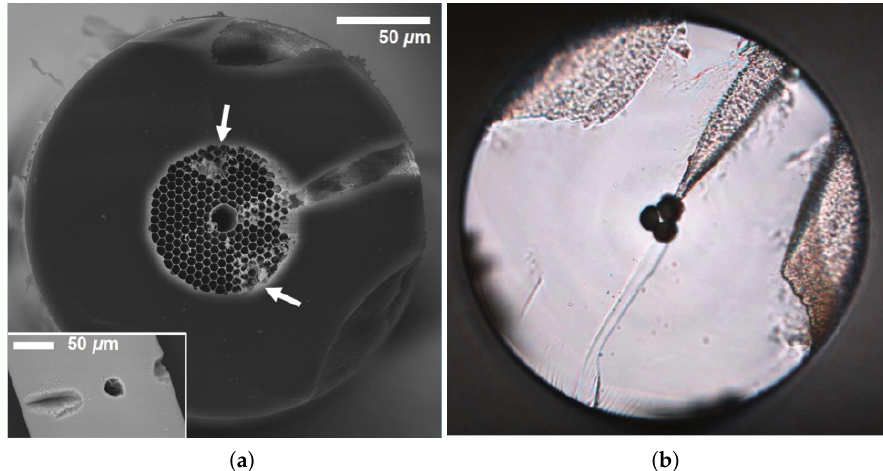
Figure 3. ( a ) SEM image of a micro-channel fabricated in a hollow-core photonic bandgao fiber: arrows indicate damage caused by laser “scoring” (inset shows channel and “scoring” lines on uncoated fiber surface, prior to cleaving); ( b ) optical microscope image showing the cross section of a microchannel fabricated in a SCF, reprinted with permission from